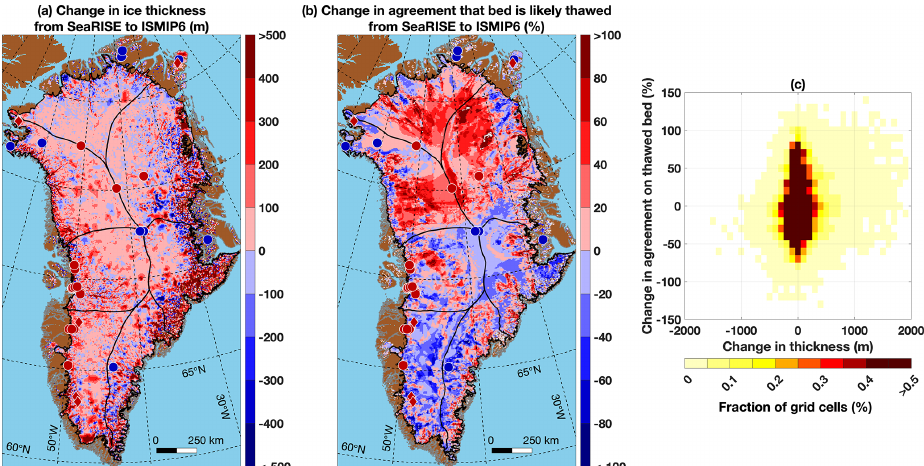
Figure 9. (a) Change in ice thickness between the most commonly used syntheses for SeaRISE (Bamber et al., 2001, with modifications) and ISMIP6 (Morlighem et al., 2017) on the 5km grid used in this study. (b) Change in agreement in modeled basal thermal state from SeaRISE (Fig. 4 of M16) to ISMIP6 (Fig. 3), where a positive (negative) difference indicates greater agreement that the bed is thawed (frozen). Values greater than ± 100% indicate that model agreement in the basal thermal state changed significantly. (c) Histogram of change in ice thickness vs. change in model agreement of a likely thawed